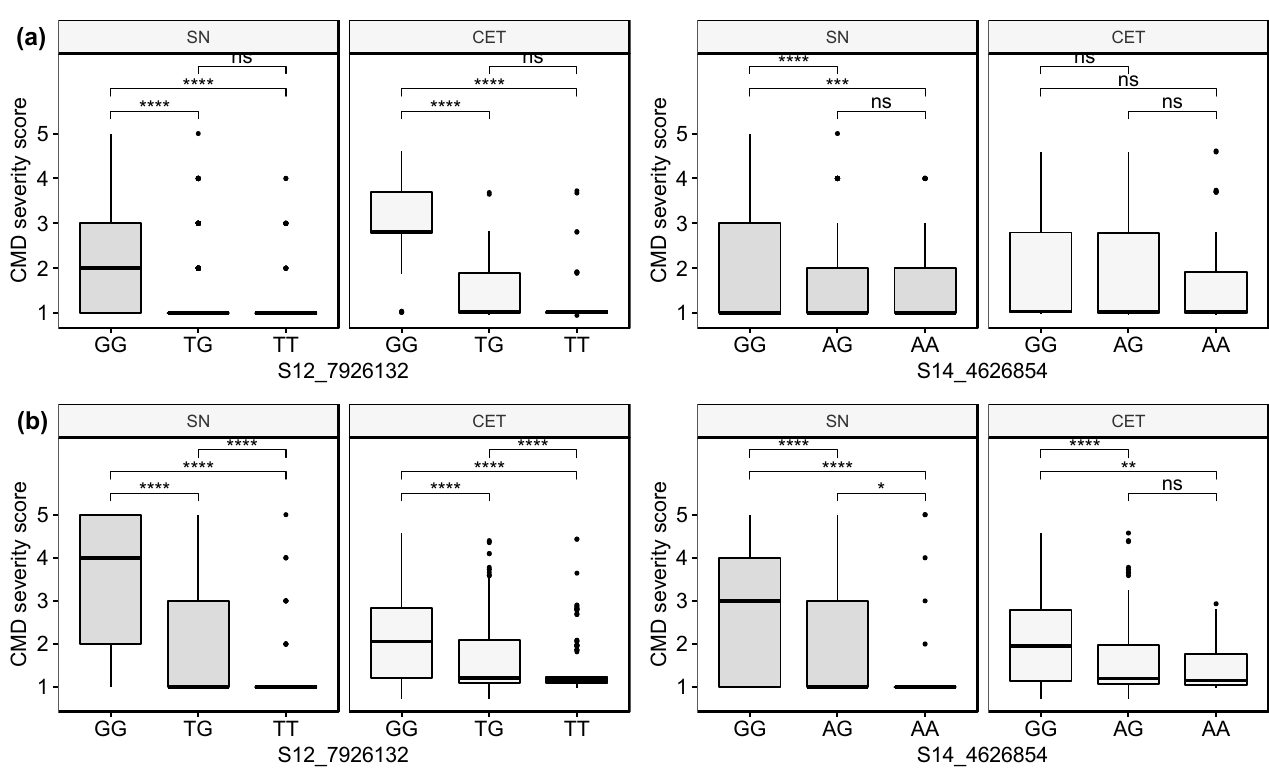
Figure 3. Boxplots showing the effect of the markers associated with CMD resistance in ( a ) breeding and ( b ) prebreeding populations of the two evaluation stages (SN = seedling nursery, CET = clonal evaluation trial). **** indicates p < 0.0001, *** indicates p < 0.001, ** indicates p < 0.01, * indicates p < 0.05, ns = not significant.